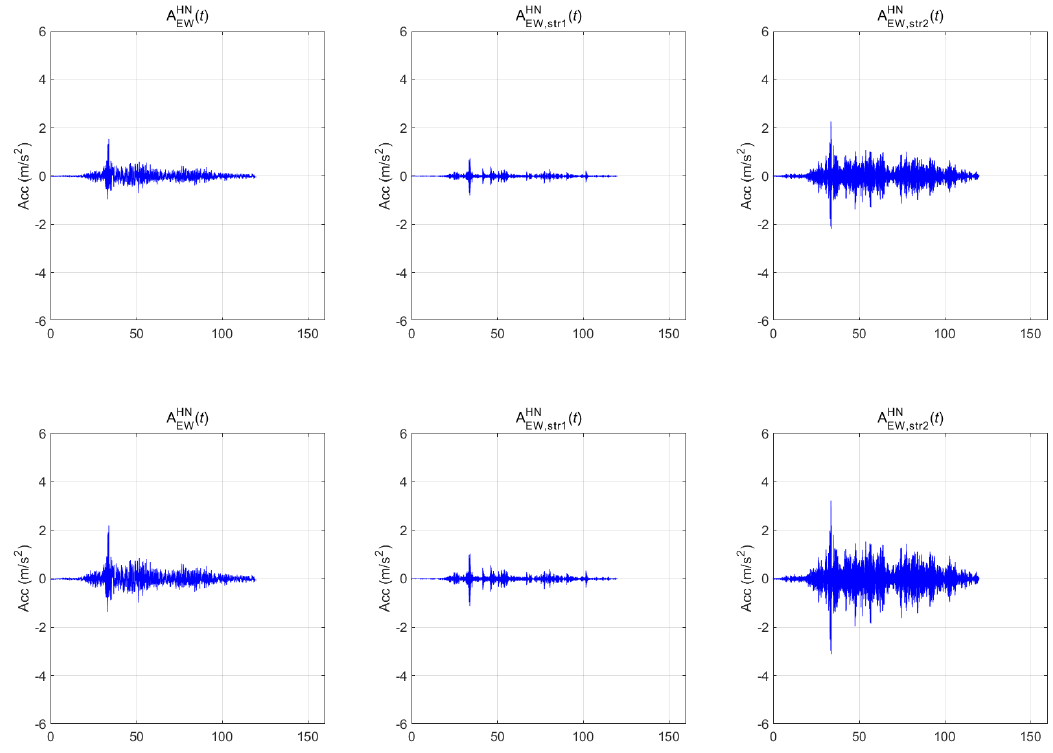
Figure 9. Bridge responses of the Hachinohe earthquake.